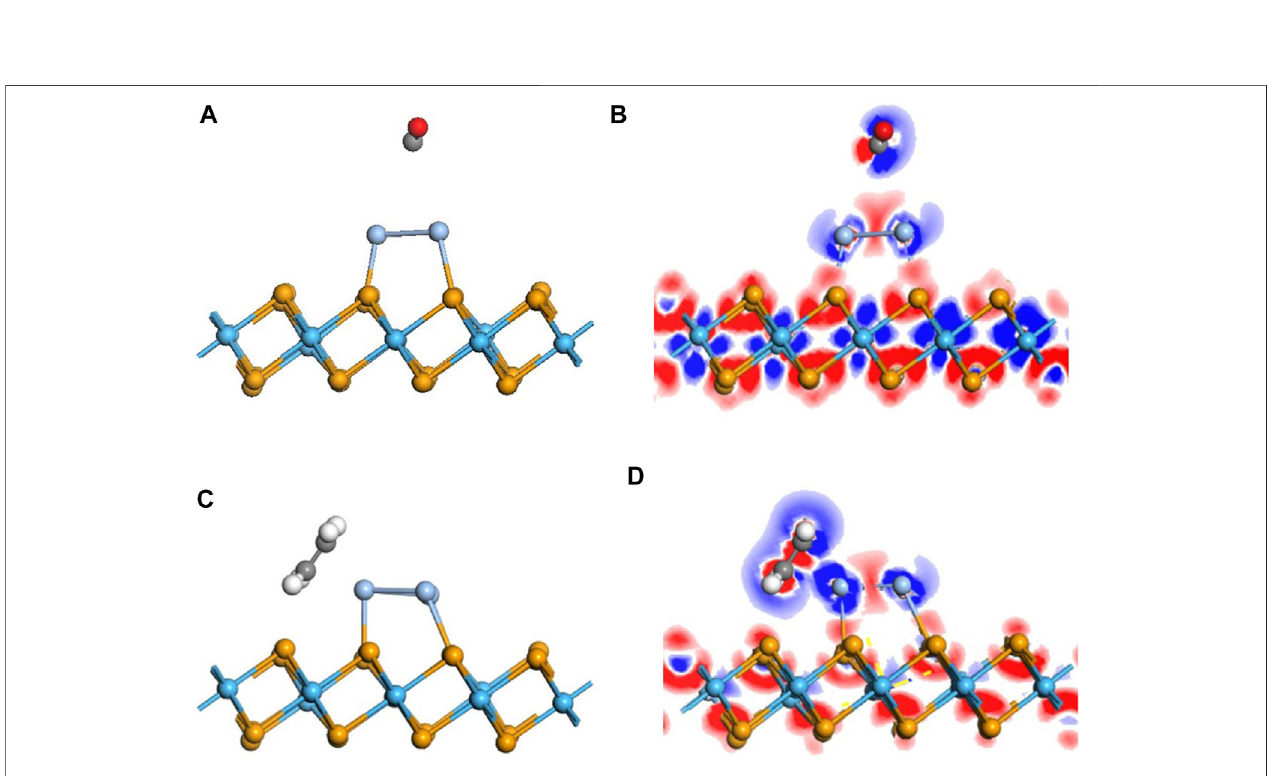
FIGURE 4 | Geometric and electronic structures of the adsorption system of CO and C 2 H 4 on the doped Ag 3 – HfSe 2 monolayer. (A,B) Adsorption system of CO and related DCD. (C,D) Adsorption system of C 2 H 4 and related DCD.